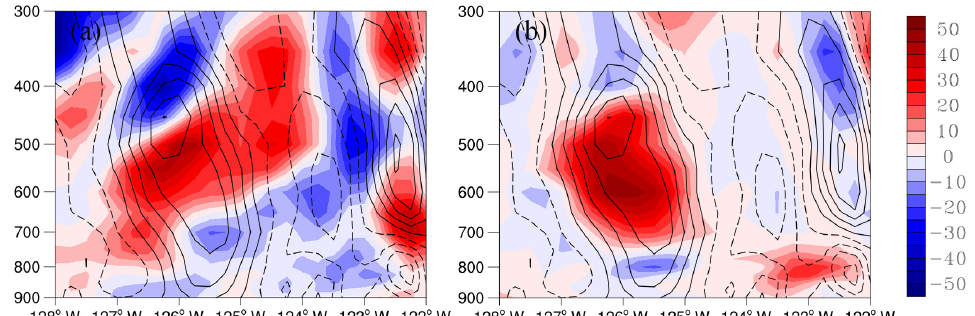
Figure 11. The zonal–vertical section of ( a ) Γ 0 → 2 (shadings; in 10 − 4 m 2 s − 3 ) and ( b ) − b 2 (shadings; K in 10 − 4 m 2 s − 3 ) averaged over the zonal band 38 ◦ –40 ◦ N on 26 February at 18:00 UTC. Contours of the mesoscale vertical velocity ( − ω ∼ 2 ; in Pa/s) are overlayed with an interval of 0.15 (solid contours for the ascending motion).